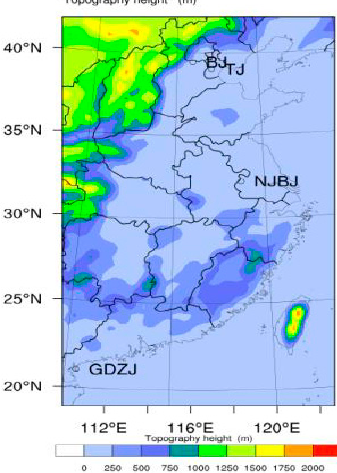
Figure 1. Tianjin test area and other mentioned fog test areas in China. Table 1. Instrumentation and measurements for the winter fog observations in Tianjin.